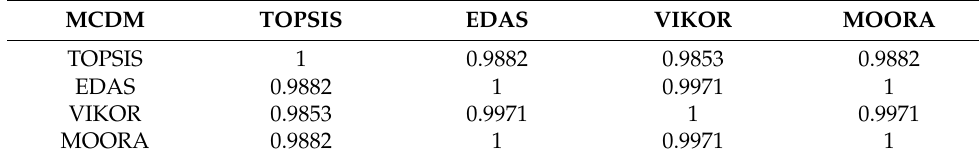
Table 3. Spearman’s rank correlation coefficients between MCDM methods for case study 1.